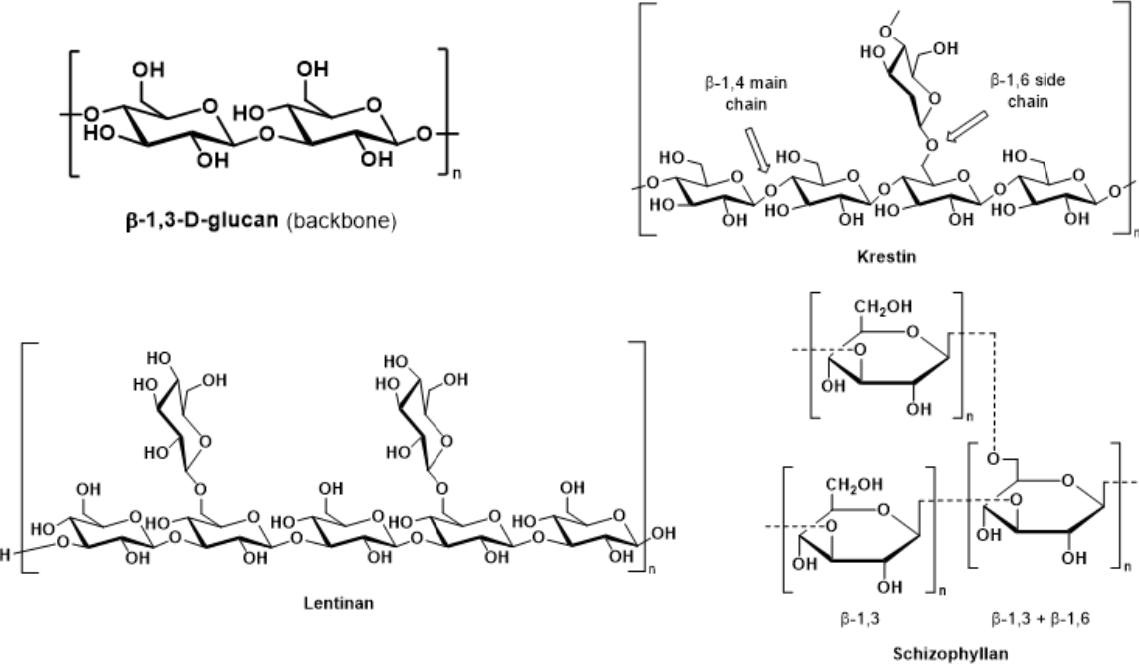
Figure 2. Chemical structures of anticarcinogenic mushroom